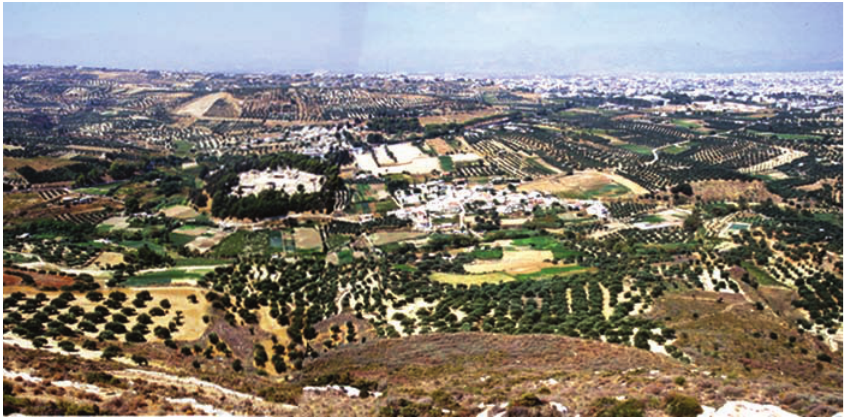
Figure 3 The Knossos valley from the southeast, the prehistoric palace at centre left, Heraklion at top